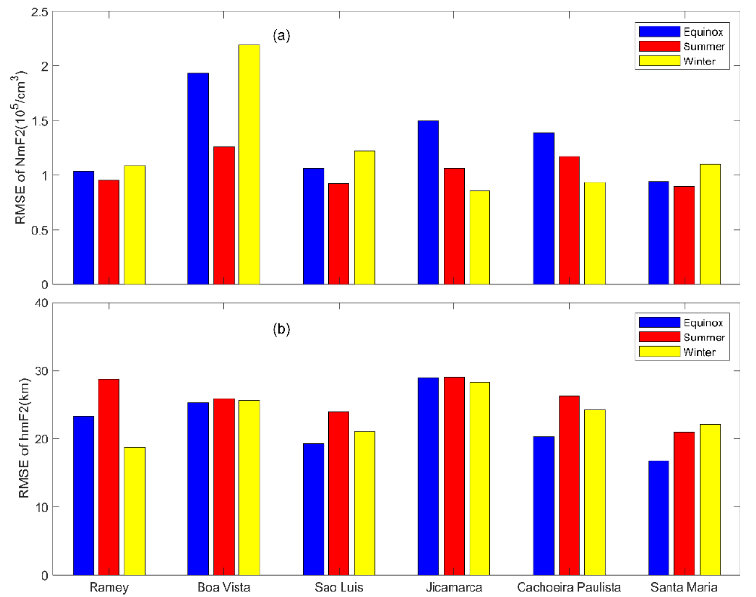
Figure 8. Seasonal RMSE of NmF2 ( a ) and hmF2 ( b ) during the equinox (blue), summer (red), and winter (yellow) periods at each station.